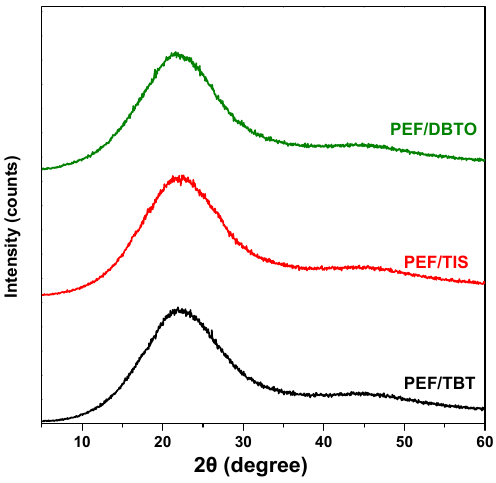
Figure 1. WAXD patterns of as the prepared poly(ethylene furanoate) (PEF) samples after melt polycondensation using different catalysts (TBT, TIS, and DBTO).